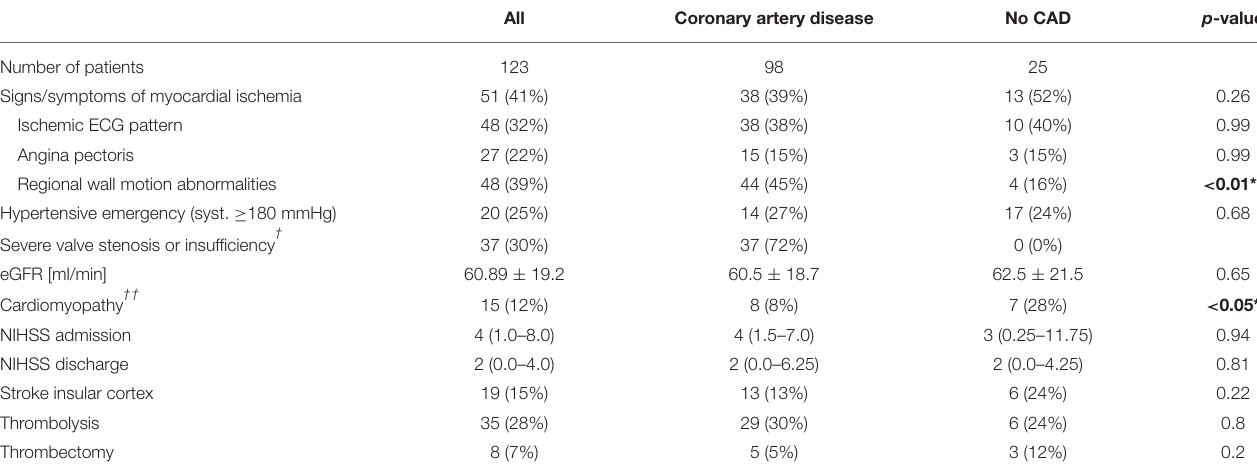
TABLE 2 | Parameters of patients with no angiographic evidence for CAD.